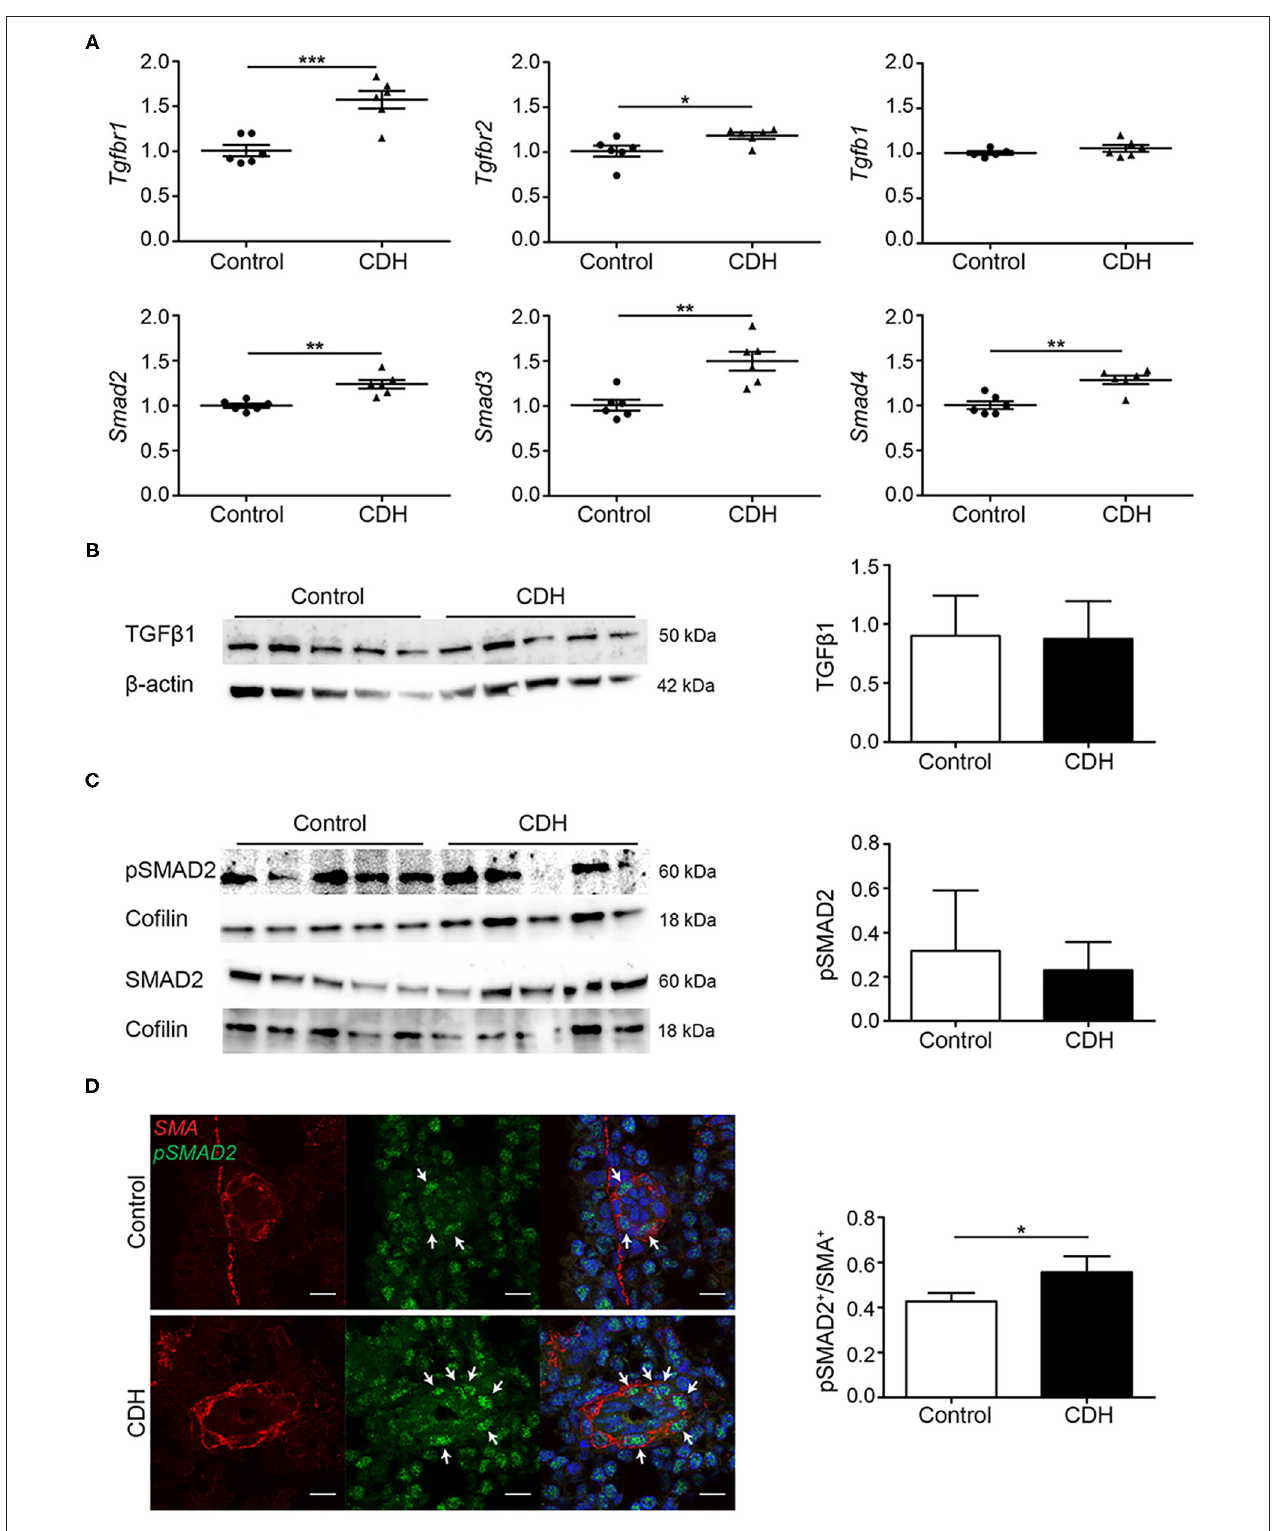
FIGURE 2 | TGF β activation is upregulated in experimental CDH. (A) Quantitative PCR revealed a significant increase in Tgfbr1 and Tgfbr2 in CDH ( p < 0.001 and p = 0.033, respectively), but no difference in Tgfb1 mRNA transcript abundance compared to control. The abundance of Smad2 , Smad3 , and Smad4